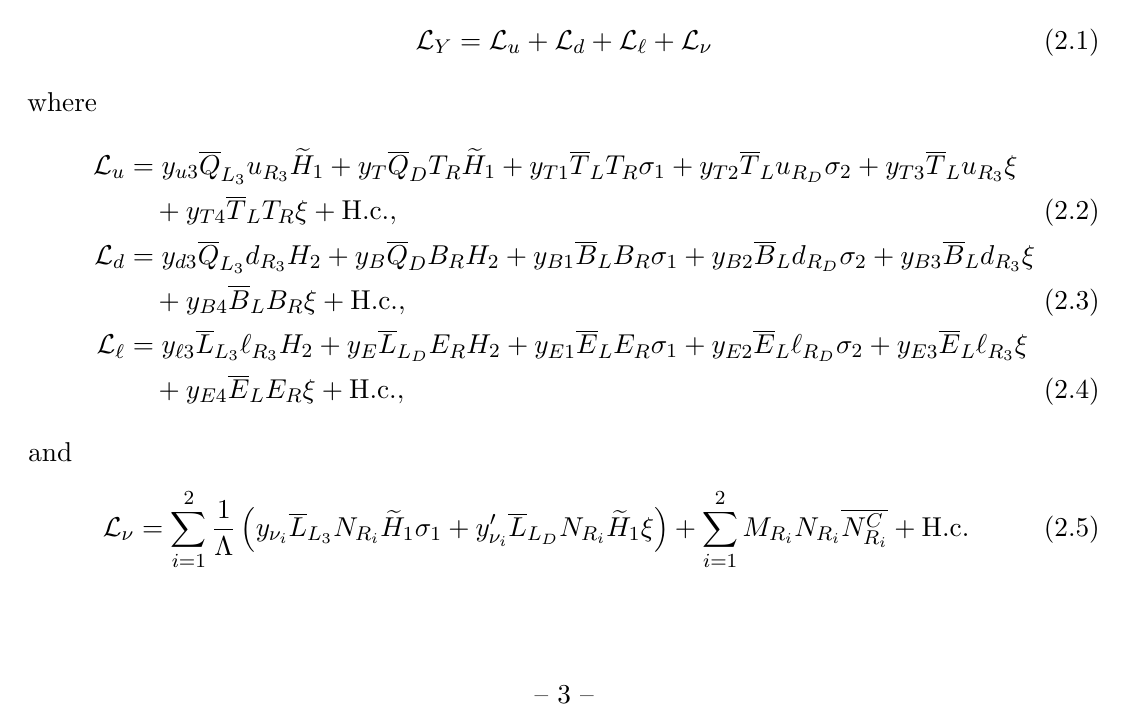
Table 2. Assignments of the singlet scalars and exotic fermions under the Q irreps. For convenience we have not included a subindex D for Q 6